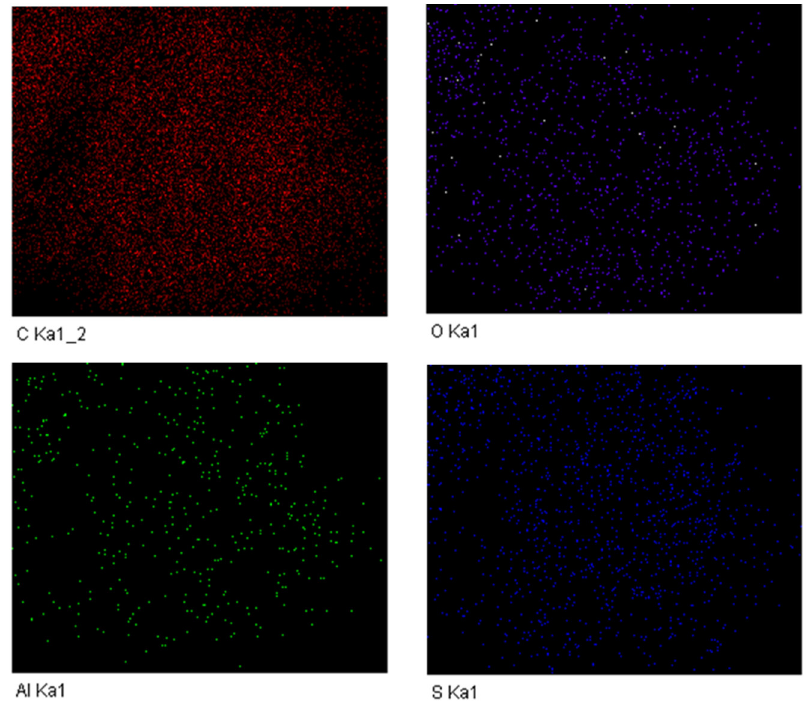
Figure 3. EDS elemental mapping of LA-MWCNT.